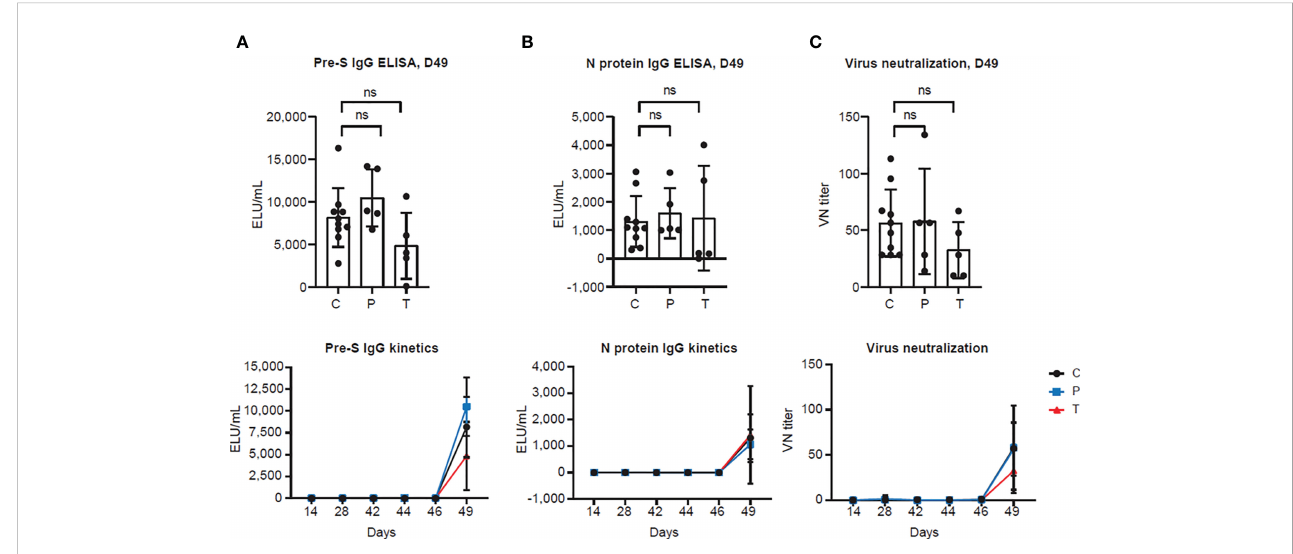
FIGURE 3 PolyPEPI-SCoV-2 does not induce antibody secretion and virus neutralization (A, B) Antibody response measured by (A) pre-S and (B) N protein IgG ELISAs from hamster sera. Results are shown as average of secreted antibodies (ELU/mL) ± SD of 5 animals per group (or 10 in the Controls group) measured in duplicates from D14 to D49 (lower panel) and separately illustrated on D49 (upper panel). (C) SARS-CoV-2 neutralization titers were measured by virus neutralization assay. Results are shown as average of virus neutralizing (VN) titer ± SD of 5 animals per group (or 10 in the Controls group) measured in triplicates from D14 to D49 (lower panel) or separately illustrated on D49 (upper panel). (C) : Controls (combined challenge and adjuvant controls), P: prophylactic, T: post-exposure prophylactic. ns, non-signi fi cant result, p>0.05 by one-tailed Mann-Whitney